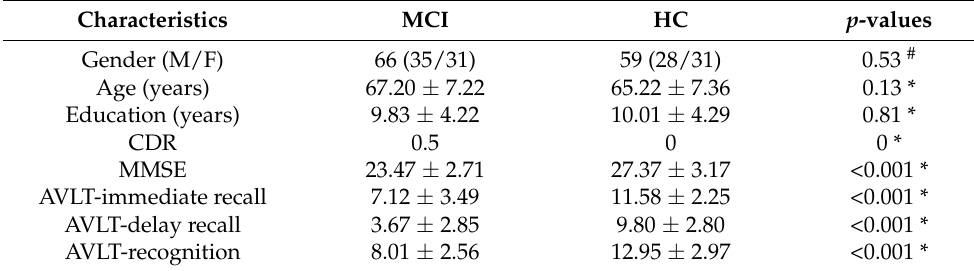
Table 1. Participants’ demographic and clinical characteristics. Characteristics MCI HC p